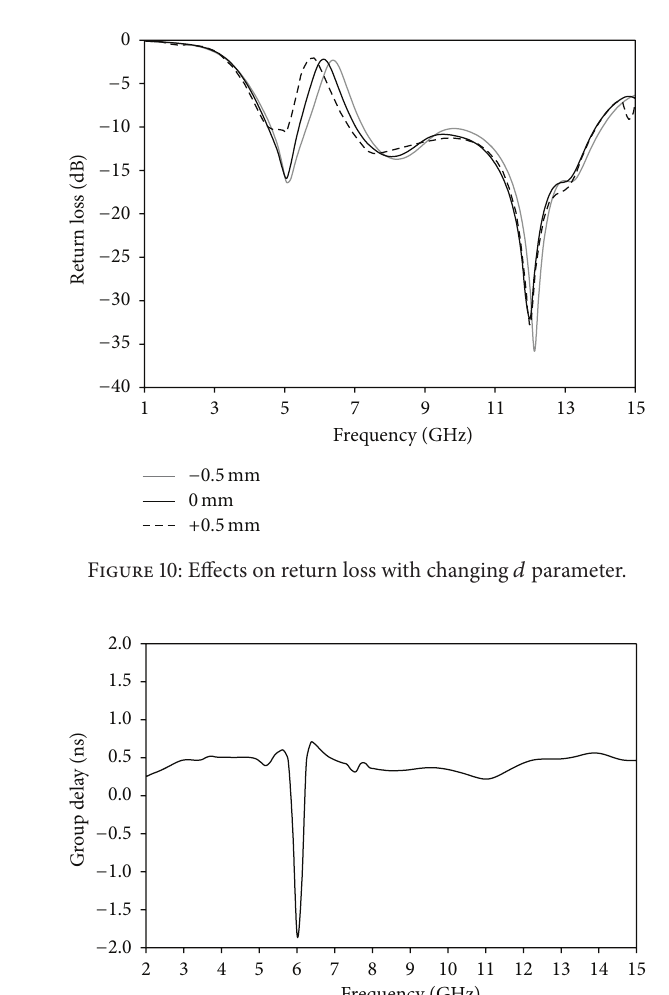
Fork-shaped notch, the antenna achieves a wide band- width of 4.33–13.8 GHz with a rejection frequency band